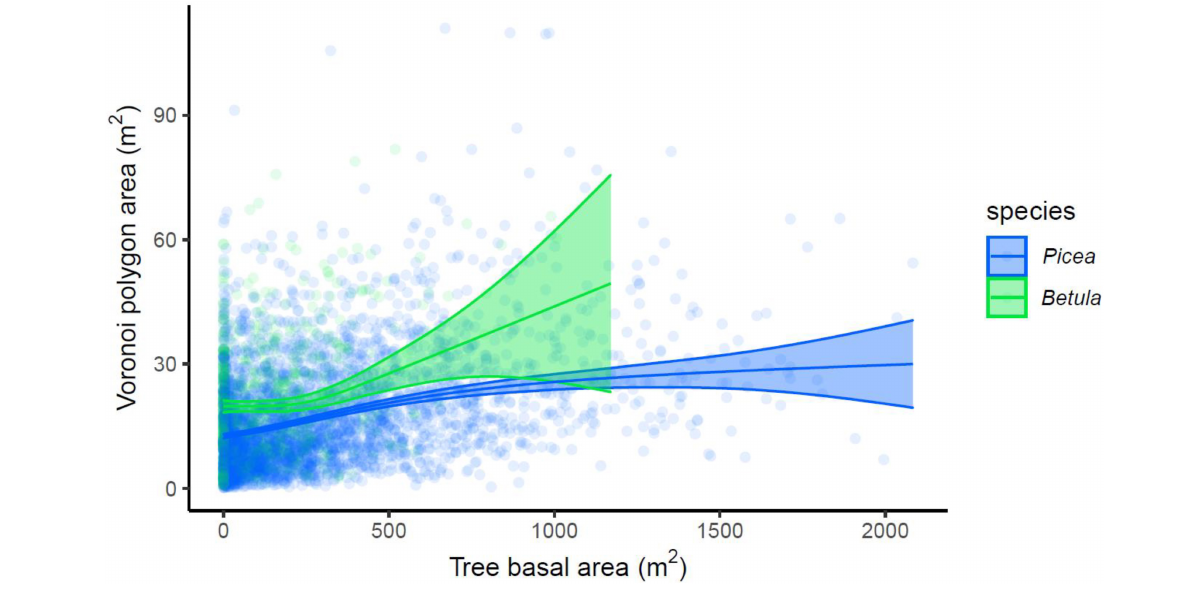
FIGURE 7 | Relationship between Voronoi polygon area and tree basal area, modeled for P. abies and B. pubescens with generalized additive models (GAM), with 95% confidence